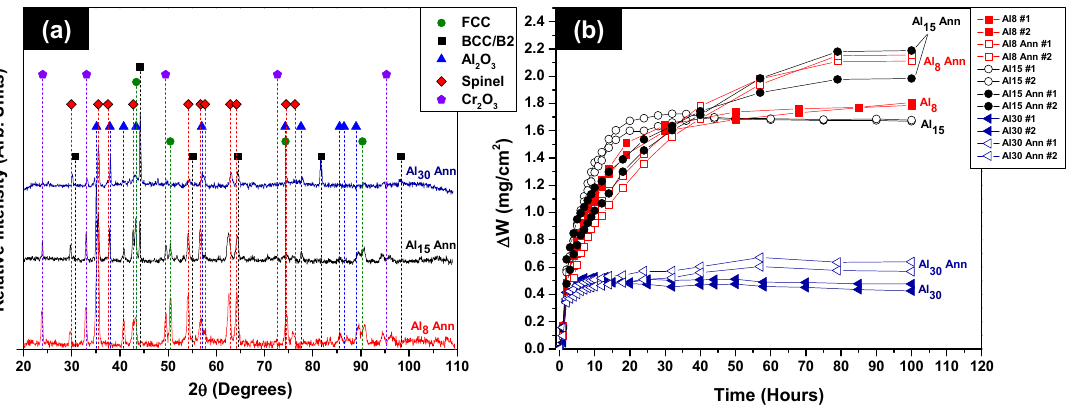
Figure 4. XRD patterns for the annealed HEAs after 50 h of oxidation at 1050 °C in air ( a ); and normalized mass change curves for the as ‐ cast/oxidized and annealed/oxidized HEAs ( b ). Table 3. Parabolic oxide rate constants ( k P ) calculated for the as ‐ cast and annealed HEAs.